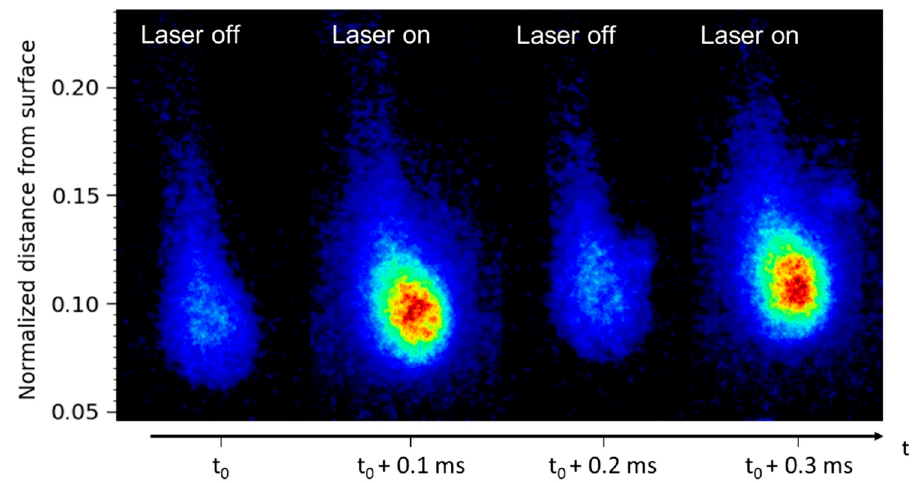
Figure 13. Sequence of four emission and LIF images at h ~1 mm. The distance from surface is normalized to the total flame height. The time delay between successive images is 0.1ms. Images are recorded during the combustion of a burning Al / AP / HTPB propellant sample at 1.0 MPa. The dynamic of the signal is 0–200 counts.